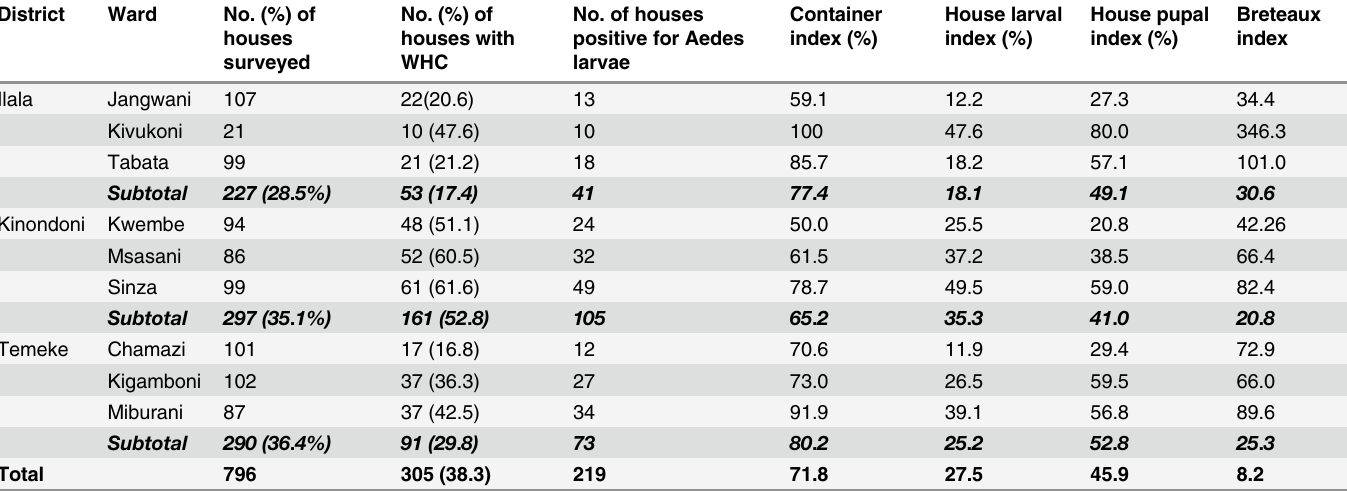
Table 3. Number (%) of houses surveyed, water holding container (WHC), house larval and pupal and Breteaux indices by district and ward in Dar es Salaam. District Ward